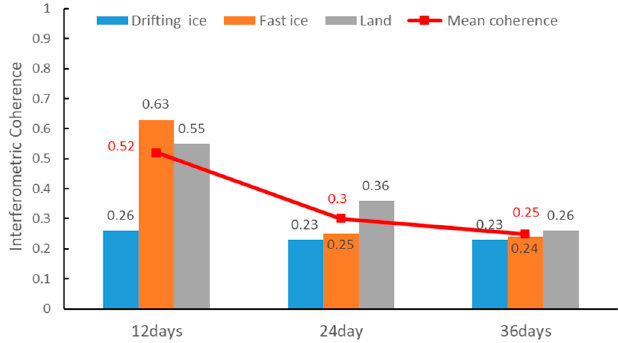
Figure 7. Coherence statistics under different temporal baselines.